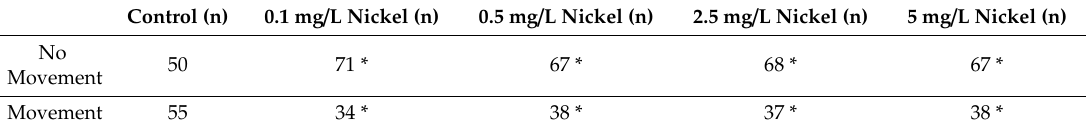
Table 1. Comparison of spontaneous movement in 24 hpf zebrafish embryos reared in medium containing 0.1–5 mg/L nickel.